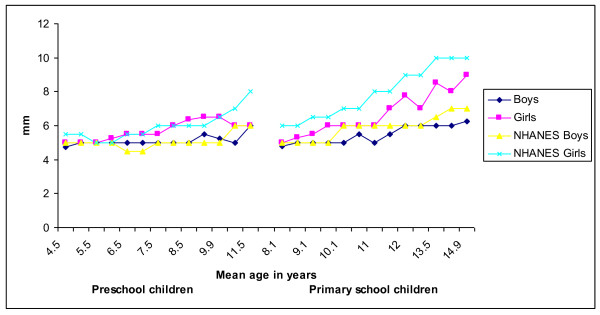
Development of median subscapular skinfold of Ellisras rural children and the NHANES III (Frisancho, 1990) reference population.